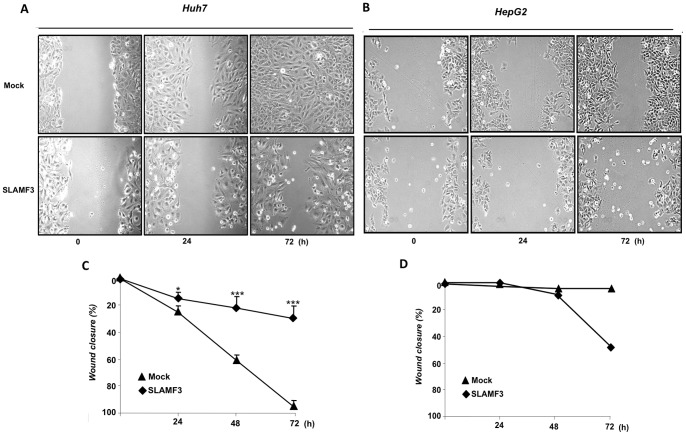
Correlation between HCC cell SLAMF3 expression and cell motility.Cell migration activities in Huh-7 (A) and HepG2 (B) cells overexpressing SLAMF3 and in mock cells were compared in a wound-healing assay. Same areas of culture plate were photographed at the indicated time points. The migratory index corresponds to the percentage of wound closure (estimated using Image J software) and presented as the mean ± SD from three independent experiments with Huh-7 cells (C) (statistical significance: *p<0.05 ***p<0.005) and from one experiment for Hep3B cells (D).